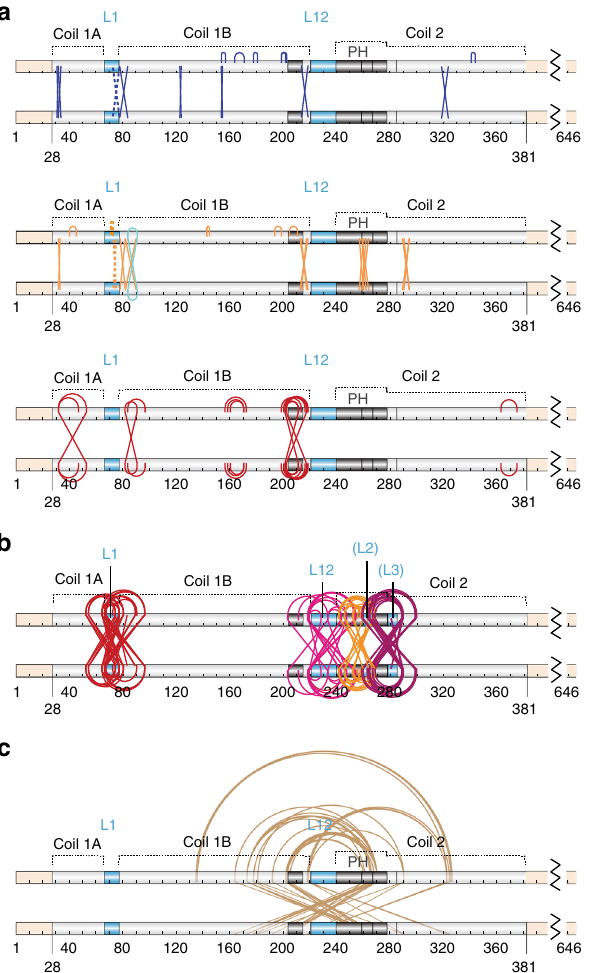
Fig. 6 Categorisation of cross-links in the lamin A rod domain. Cross-links are indicated by the lines: arced lines above indicate intra-chain cross- links; crossed lines those between — inter-chain cross-links. a Lamin A schematics showing sub-categories of cross-links. A total of 31 cross-links were found in the lamin A dimer rod domain that satisfy classical coiled coil geometry with irregularities in the coiled coil termini and PH packng: 11 intra-chain, 19 inter-chain cross-links (blue and orange lines both) and 1 cross-link occurring both ways (cyan lines). Top: cross-links satisfying the physical constraints of the EDC cross-linker and supporting predicted heptad and parallel hendecad coiled coil structure of the predicted 51 nm rod. Middle: cross-links that can readily satisfy the cross-linker physical constraints in a parallel dimer with the indicated coiled coil segments, but indicate deviations from the predicted coiled coil structure: axial chain rotation, stutters and hendecad-heptad transition associated irregularities. Bottom: red lines indicate cross-links between residues with side chain at distances exceeding EDC constraints in the predicted structural model. Only such cross-links within the coiled coil regions are shown. b Cross-links around linker regions. Most identi fi ed cross-links clustered around L1 (dark red), L12 (light red) and two putative linkers L2 (orange) and L3 (brown) historically annotated within and after PH 36,42 (see Supplementary Discussion). c Gold lines indicate all remaining cross- links within the rod